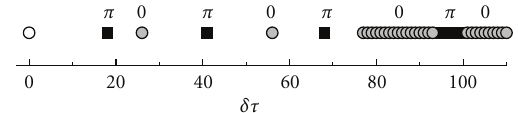
Figure 14: Steady-state distances between two solitons interacting through a lumped saturable absorber. The white circle corresponds to the first soliton. The black squares and grey circles do to the steady-state second soliton with the phase di ff erences π and 0, respectively. a = 0 . 5, D r = 0 . 01, D i = 0 . 1, q = 1 . 5, p = 1, s nl =